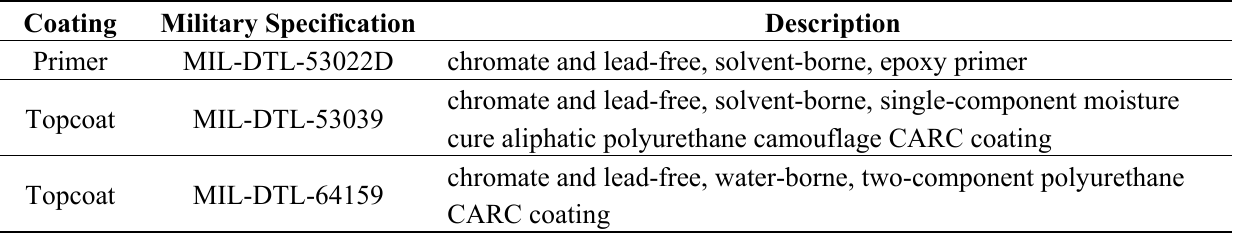
Table 1. Army primers and topcoats used for laboratory and field